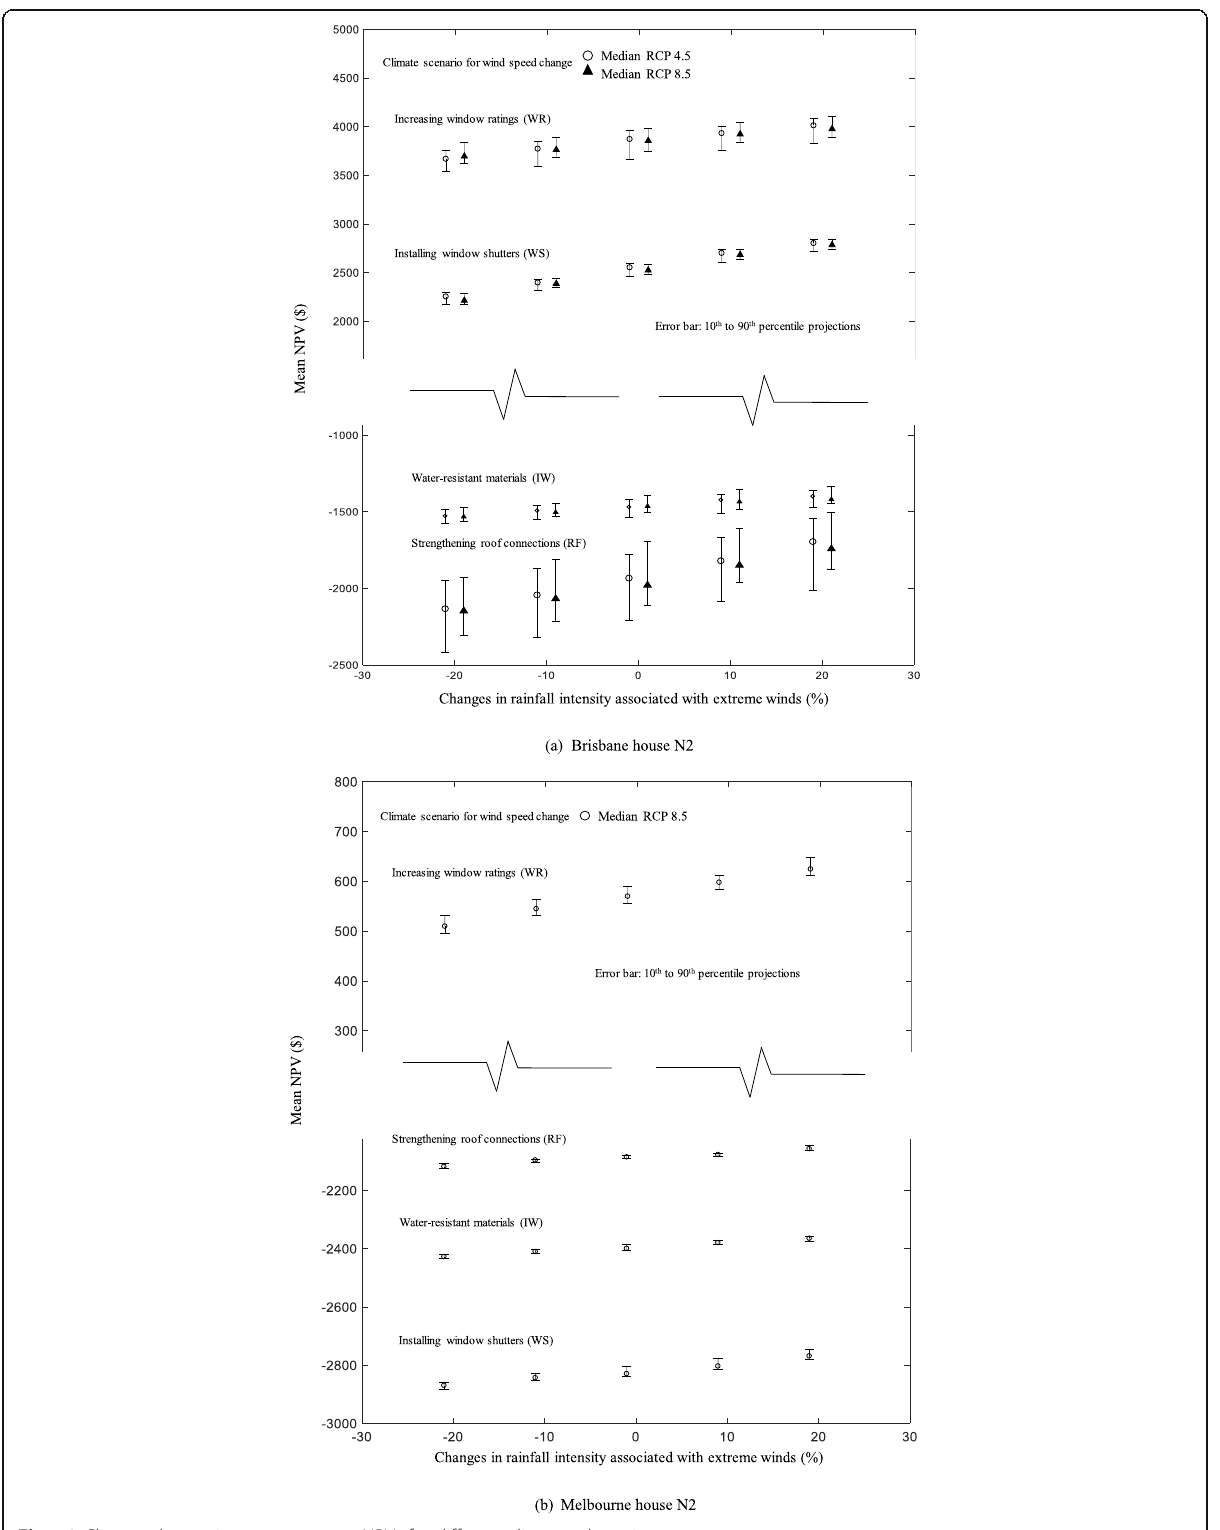
Fig. 12 Climate change impacts on mean NPVs for different climate adaptation